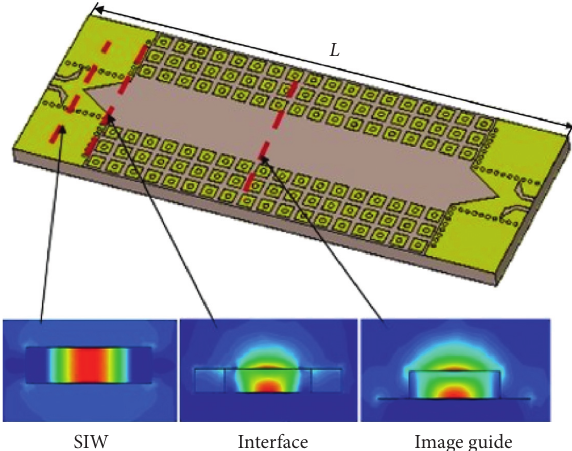
Figure 9: Mode conversion from the feeding structure to guiding channel. The length of the structure L � 71.2 mm.